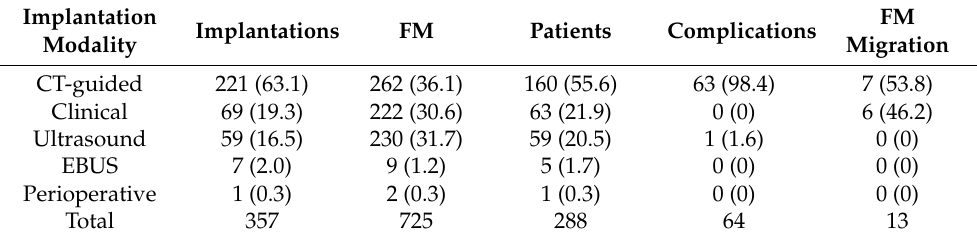
Table 2. Fiducial marker implantation characteristics.